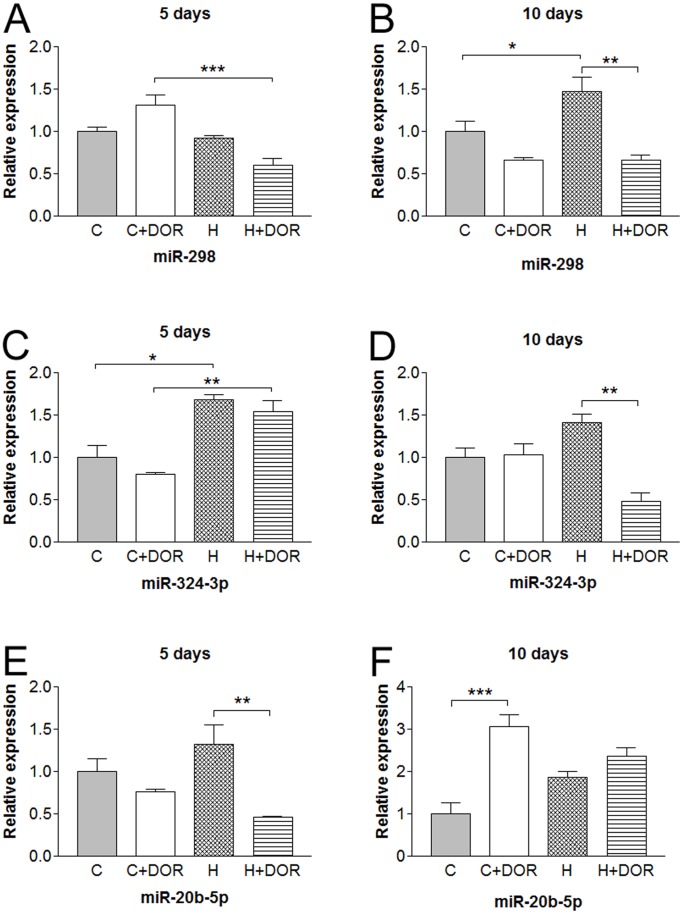
Relative miRNA expression levels of miR-298, miR-324-3p, and miR-20b-5p in the kidney following either 5 or 10 days of hypoxia as determined by quantitative RT-PCR.C, control; C+DOR, control+UFP-512; H, hypoxia; H+DOR, hypoxia+UFP-512. *p<0.05, **p<0.01, ***p<0.001.